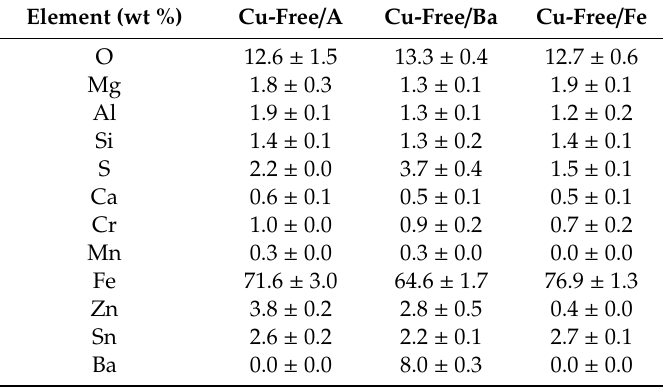
Figure 6. SEM high magnification observations of worn pins’ surface. Above: backscattered electrons images. Below: secondary electrons images. Table 3. Elemental compositions, in weight percentage, of the secondary plateau from worn surface of the three friction materials.